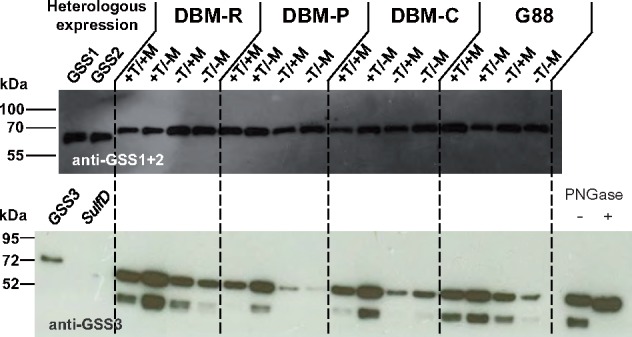
GS-dependent expression of arylsulfatase genes from Plutella xylostella. Larval gut protein was extracted from four P. xylostella strains, DBM-R, -P, -C, and G88, after herbivory on Arabidopsis wildtype (+T/+M) or mutants impaired in GS biosynthesis, myb28/29 (+T/−M), cyp79b2/b3 (−T/+M) and cyp79b2/b3/myb28/29 (−T/-M); T = Trp-GS, M = Met-GS. Western blot hybridization was conducted with anti-GSS1/2 (upper panel) or anti-GSS3 (lower panel). Recombinant GSS1 and GSS2, and GSS3 and SulfD were included as controls. Prior to gel loading all samples in the upper panel were treated with PNGase F. In the lower panel, only one sample (right) was treated with PNGase F, showing that two bands detected with anti-GSS3 merged into a single band upon removal of N-linked oligosaccharides. Upon hybridization with anti-GSS1 + 2, samples showed only minor variation in hybridization intensity. By contrast, GSS3 protein abundance was strongly dependent on plant GS profiles. In particular, presence of Trp-GS in the absence of Met-GS (myb28/29) led to high GSS3 abundance whereas absence of Trp-GS (cyp79b2/b3 and cyp79b2/b3/myb28/29) resulted in lowered GSS3 abundance compared with Arabidopsis wildtype (Col-0).